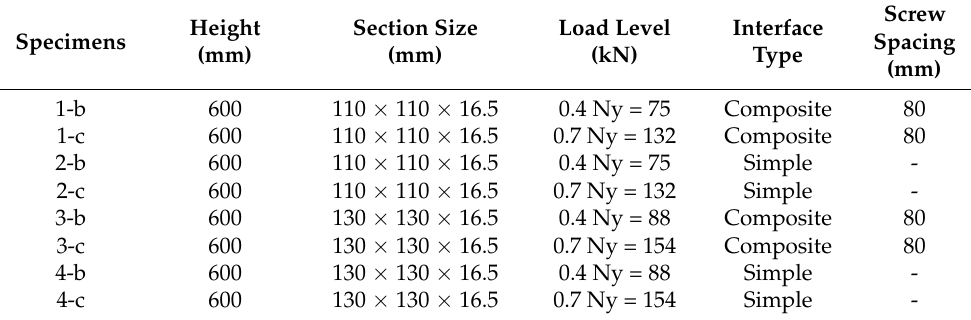
Table 3. Parameters of specimens.